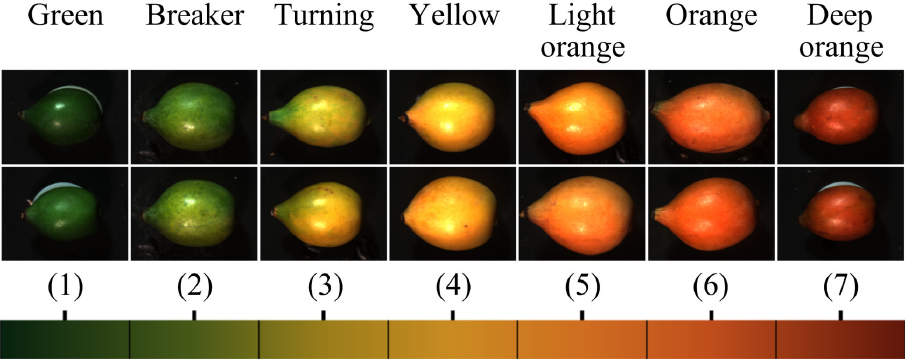
Figure 1. Seven ripeness stages of achacha